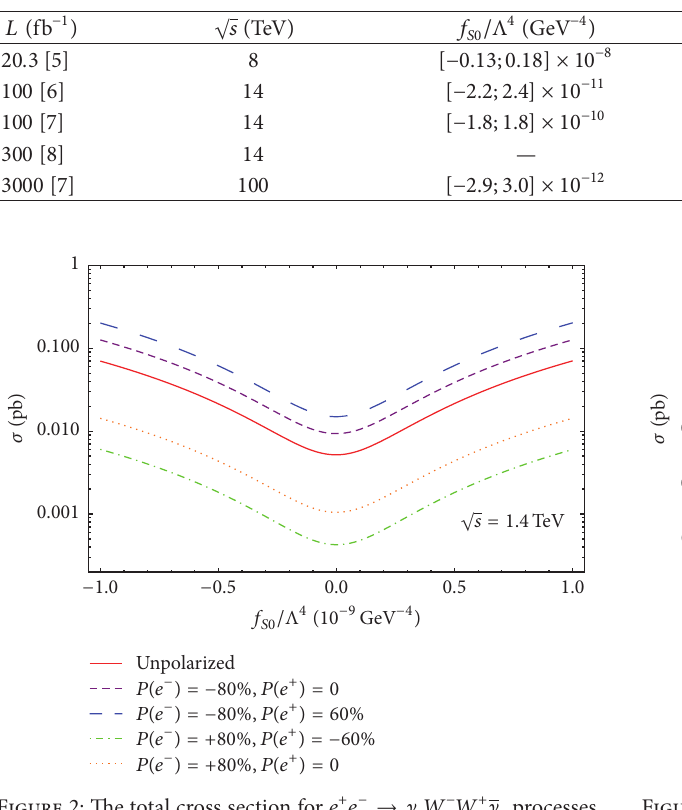
Figure 2: The total cross section for 𝑒 + 𝑒 − → ] 𝑒 𝑊 − 𝑊 + ] 𝑒 processes as a function of 𝑓 𝑆0 /Λ 4 at the √𝑠 = 1.4 TeV for different polarization of the positron and electron beams.